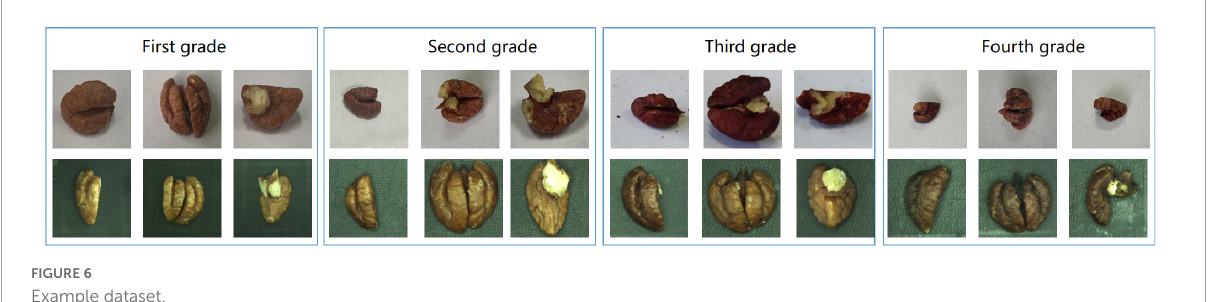
FIGURE6 Example